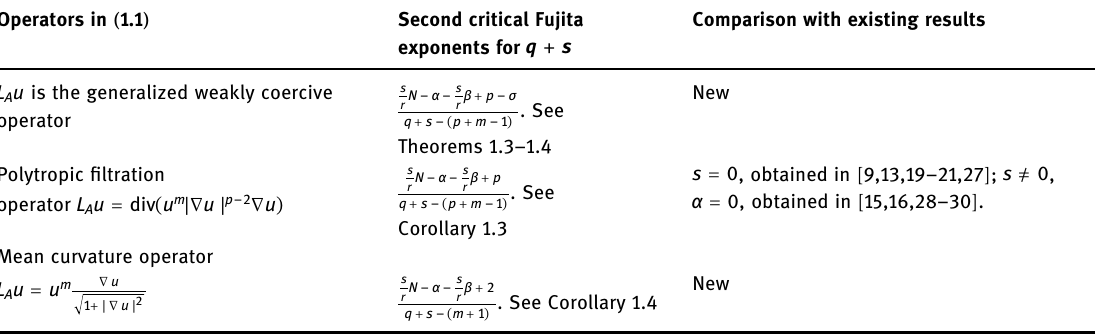
Table 2: Second critical Fujita exponents Operators in ( 1.1 )